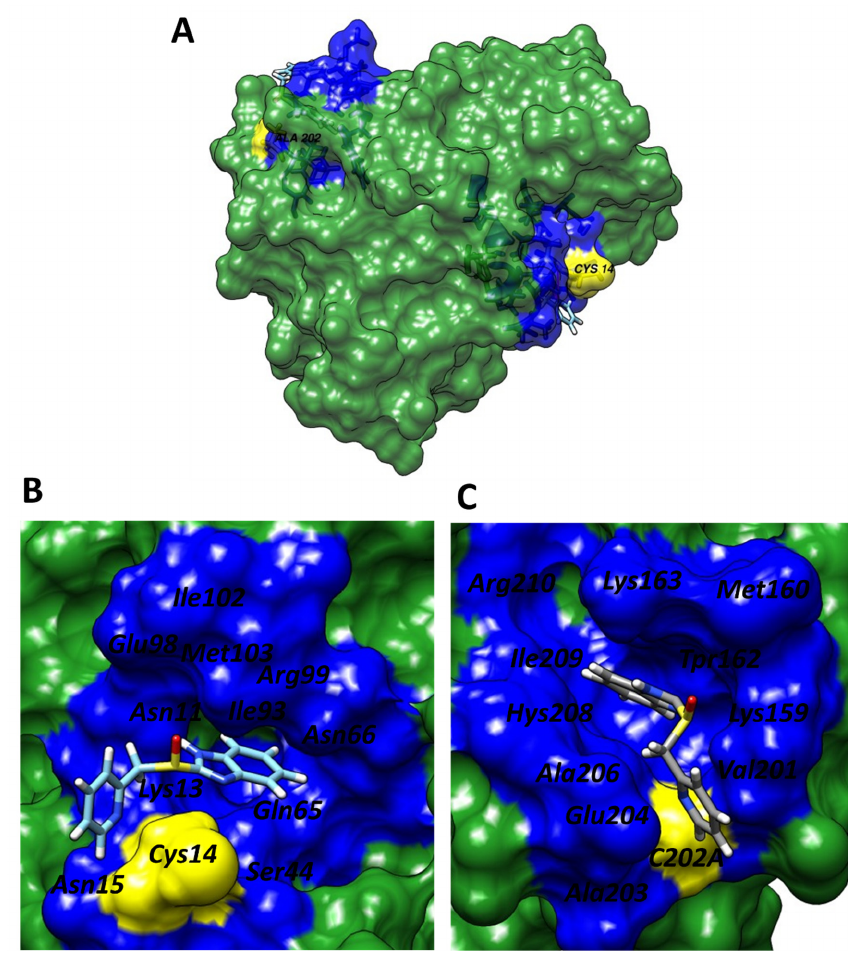
Figure 9. Docking prediction between TPI protein (PDB entry 4BI7) from Giardia lamblia with the compounds . ( A ) A general view of the binding affinities of all the antigiardial compounds with the TPI from G. lamblia . ( B ) First zone of interaction of all the compounds with the amino acids common to the binding pocket (blue) near Cys14 (yellow). ( C ) Second zone of interaction of all the compounds in the TPI structure, showing amino acids common to the binding pocket (blue) near C202A (yellow). The docking predicted with compounds O 2 N-BZM7 and O 2 N-BZM9 (compounds having a nitro